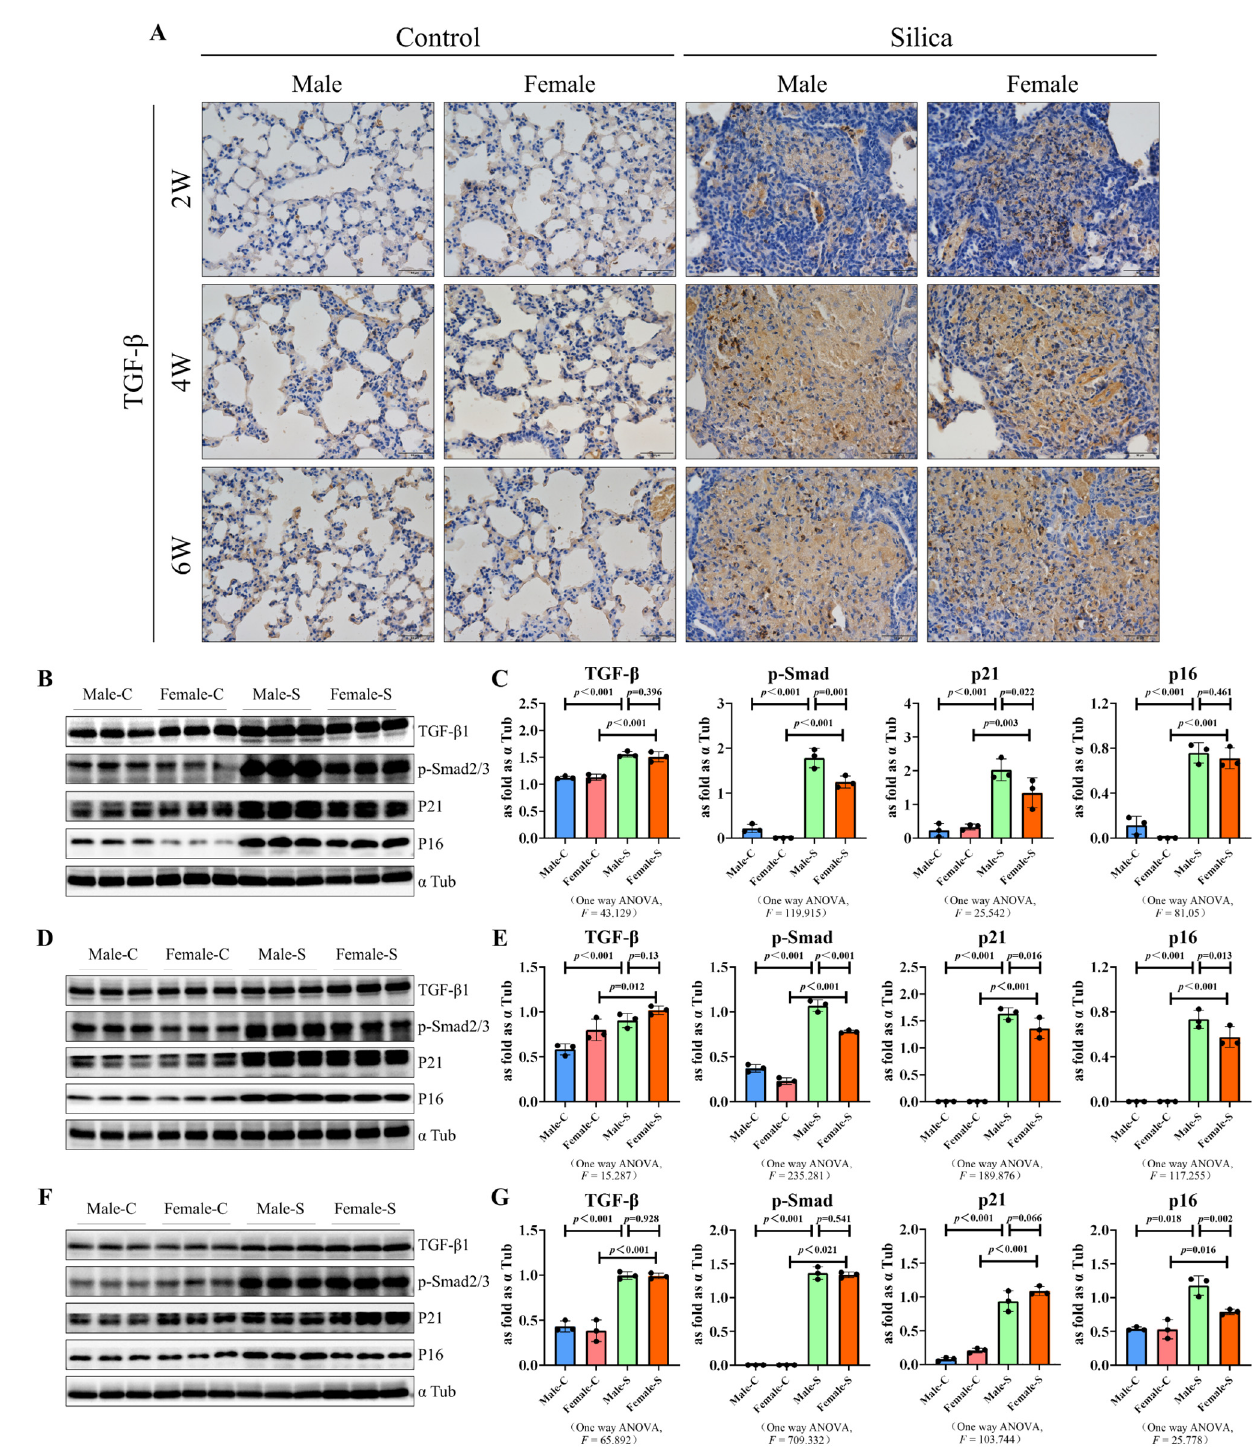
Figure 5. Western blots of TGF- β 1, p-SMAD2/3, p21, and p16 in the male and female mice exposed to silica for two, four, six weeks, and the control groups. ( A ) Immunohistochemical staining was used to detect the expression of TGF- β (brown) in the mouse lung tissues (scale bar = 50 µ m). ( B – G ) Expression levels of TGF- β 1, p-SMAD2/3, p21, and p16 in the lungs of mice were measured using the western blot. Data are presented as the mean ± SD, n = 5 per group (( B , C )—2W, ( D , E )—4W, ( F , G